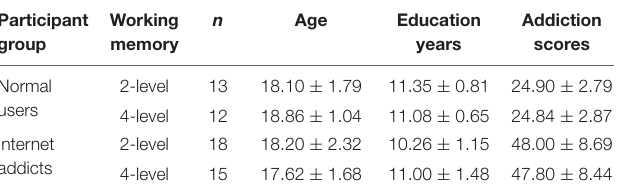
TABLE 1 | Characteristics of participants ( M ± SD